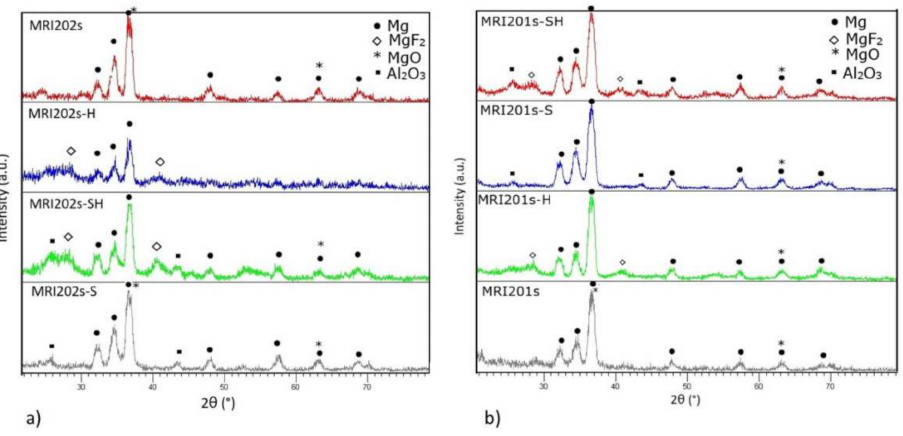
Figure 5. XRD diffraction patterns on untreated and treated alloys ( a ) MRI202s and ( b ) MRI201s. In XRD patterns for MRI201s-S, MRI201s-SH, MRI202s-S and MRI202s-SH samples Al 2 O 3 phase were detected, indicating residual particles after the sandblasting